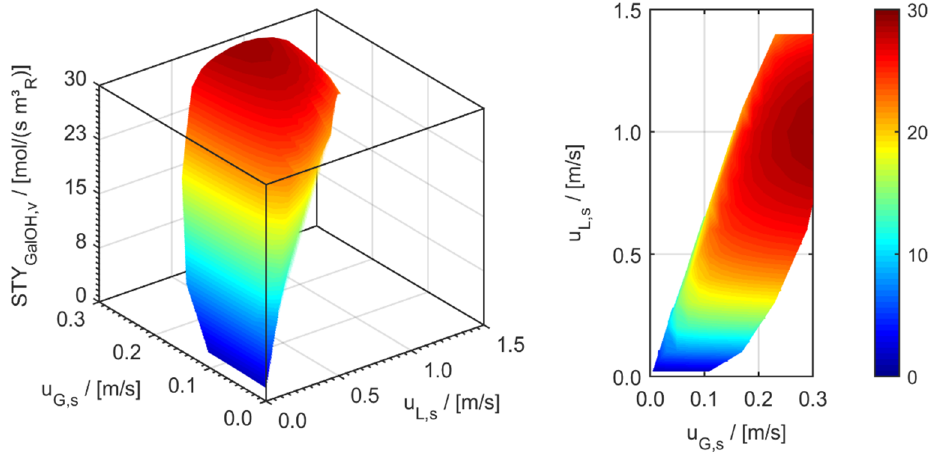
Figure 10. Volumetric space-time yield referring to galactitol in particle-packed minichannel reactors operating at different gas and liquid superficial velocities.